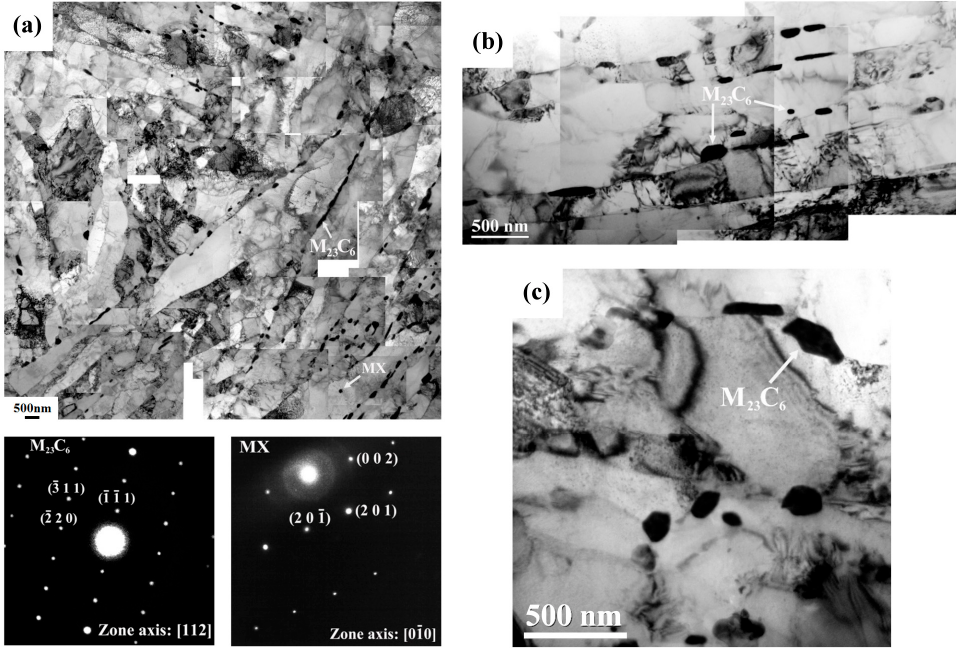
Figure 5. TEM micrographs of ( a ) BM with diffraction patterns of different carbides; ( b ) BM; and ( c ) STOT specimens in the PWHT condition.